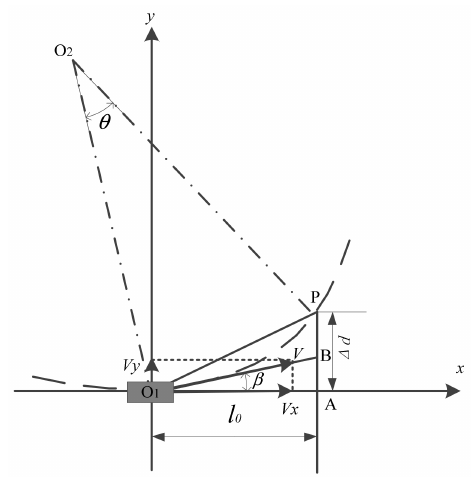
Figure 5. The vehicle track under steady circular